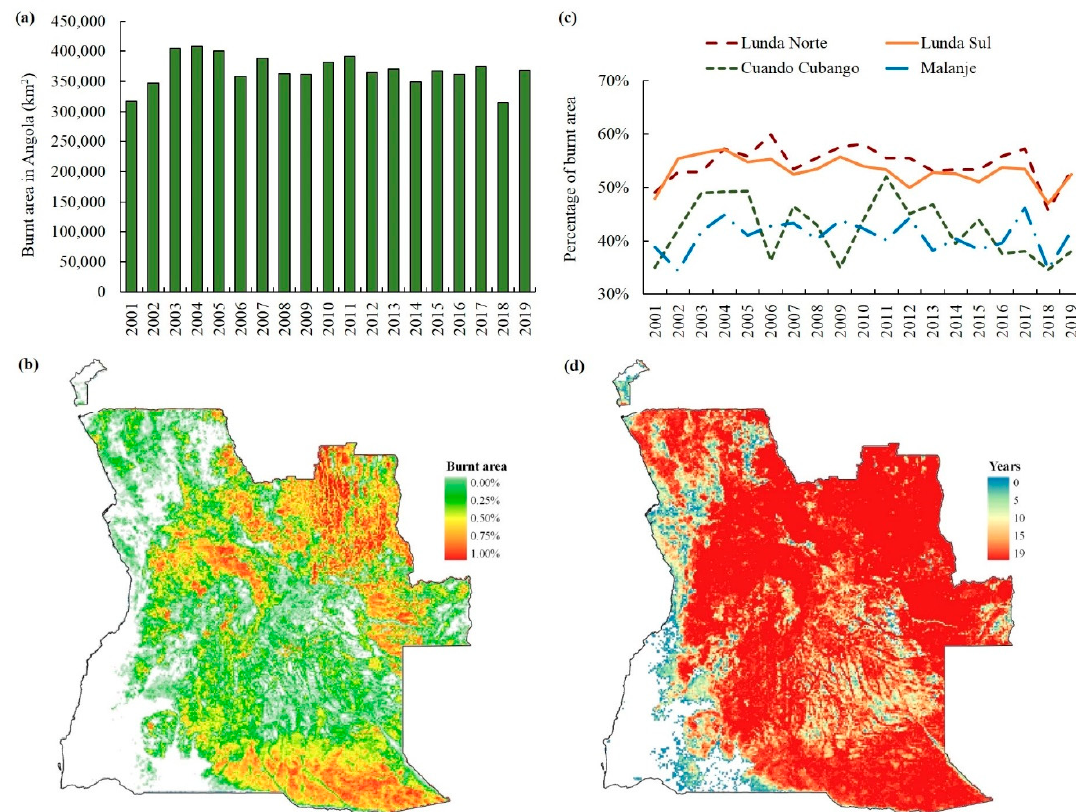
Figure 3. Burnt area in Angola, from 2001 to 2019: ( a ) Absolute burnt area (km 2 ) per year; ( b ) map of the mean annual fraction of burnt area in each cell (5 km resolution); ( c ) percentage of the area burnt in the four provinces with the highest values; ( d ) map of the number of years when each cell was completely or partially burnt since 2001 (5 km resolution).